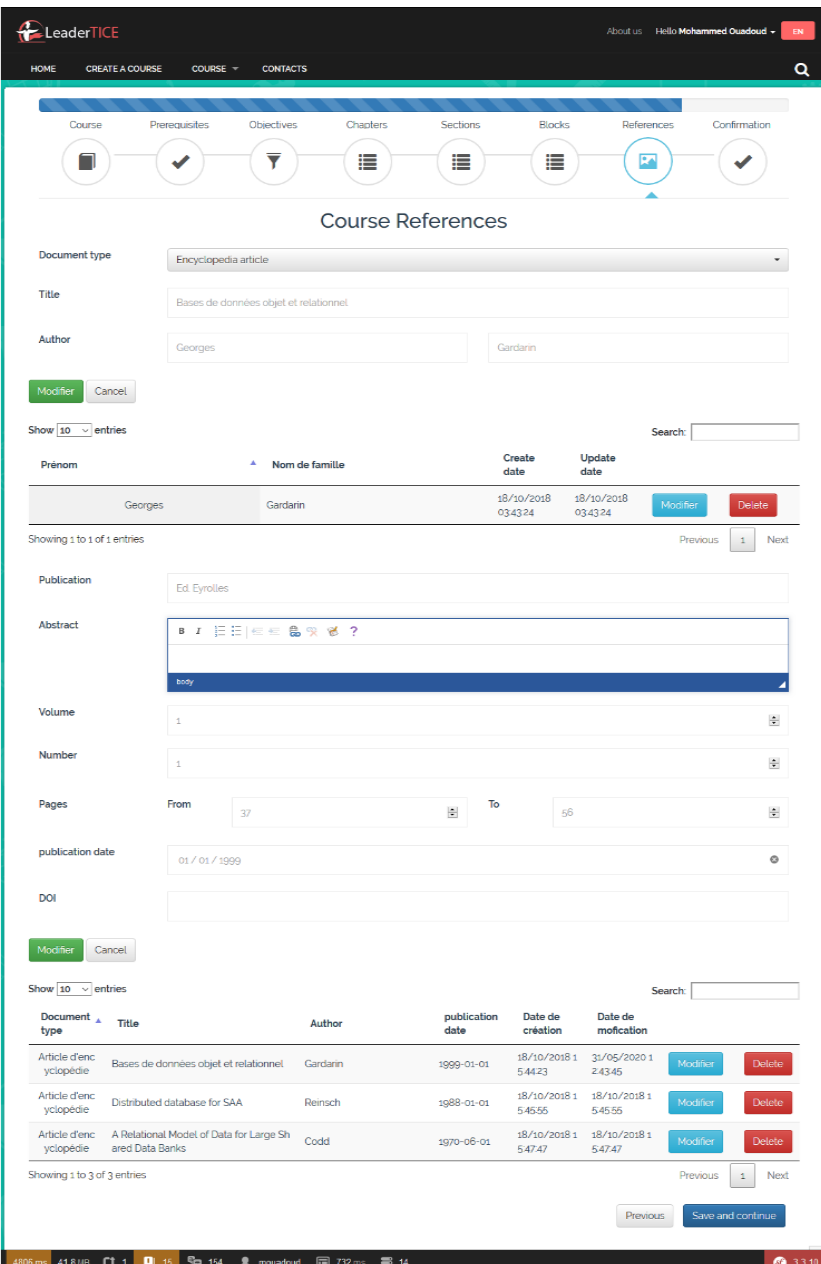
Fig. 10. Course references interface developed by the NoSQL MongoDB database and the Symfony